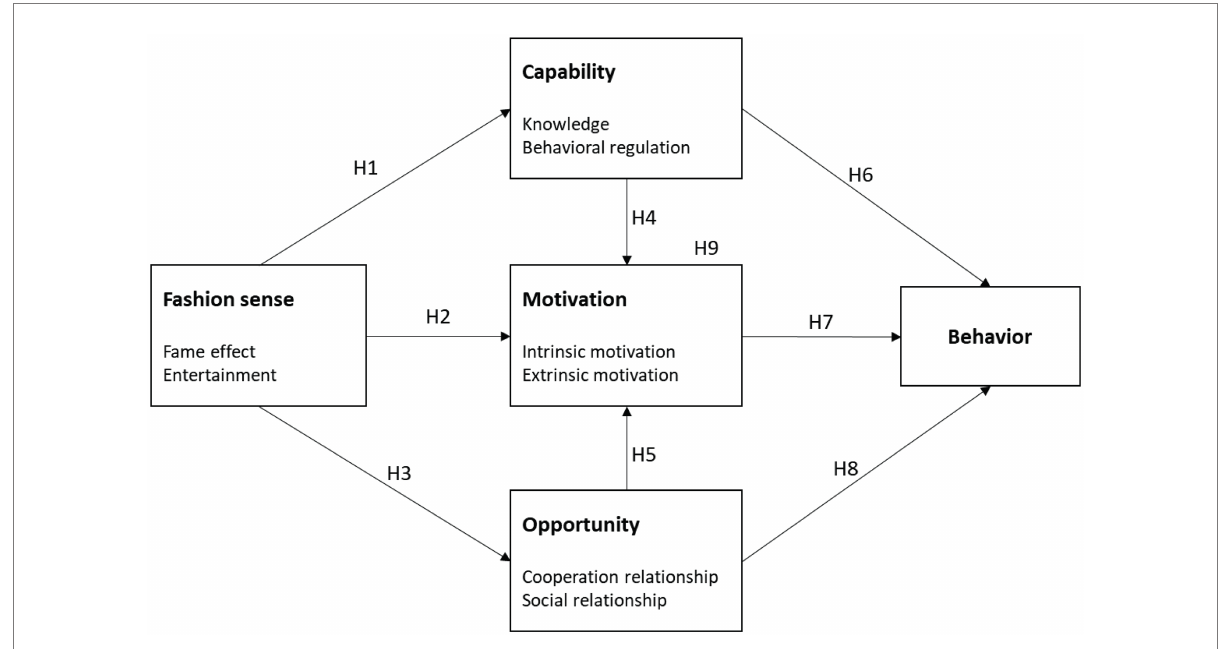
FIGURE 3 Revised COM-B